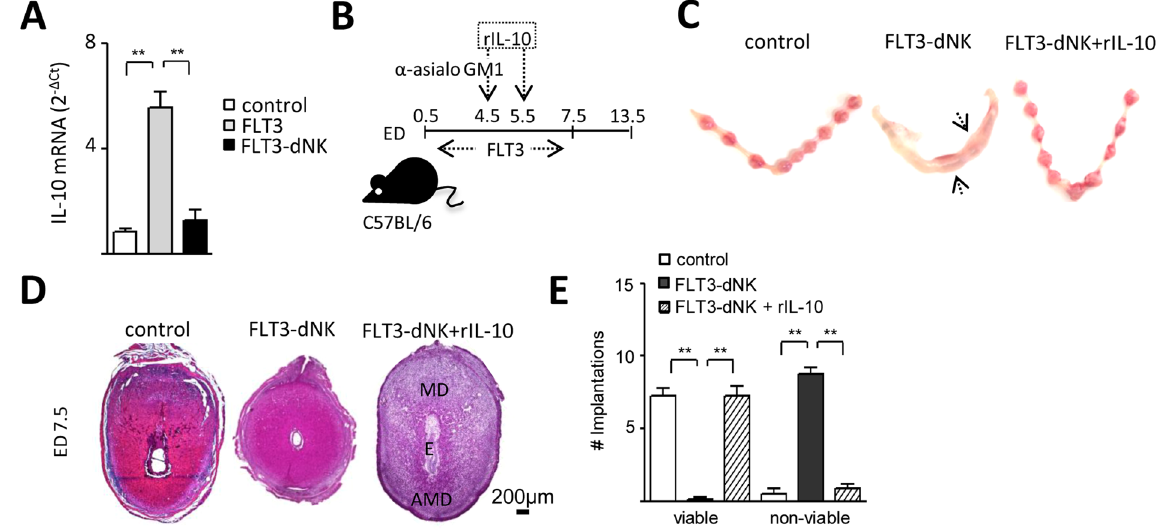
Figure 1. IL-10 rescues pregnancy failure upon NK cell depletion in FLT3-treated dams. ( A ) IL-10 expression in implantation sites from control, FLT3 treated (FLT3) and FLT3 treated- NK cell depleted (FLT3-dNK) pregnant female mice on ED7.5, as analysed by qRT-PCR. ** p < 0.01 ; as assessed by ANOVA, Tukey multiple comparisons test. ( B ) The scheme illustrates the experimental design for DC expansion and NK cell depletion during early pregnancy. Upon plug detection; female mice were injected daily with 10 μ g FLT3 i.p. + a single anti-asialo GM1 injection on ED4.5 to analyze effects of NK cell depletion upon expansion of DC (FLT3-dNK mice). Recombinant IL-10 (rIL-10) was administrated on ED4.5 and ED5.5. ( C ) Macroscopical appearance of the uterus and implantations registered during E7.5. The pictures show the normal phenotype of control and FLT3-dNK + rIL-10 implantations in contrast to that observed in FLT3-dNK mice, which exhibit completely resorbed embryos. ( D ) Microscopical assessment of H&E stained implantation site sections revealed abnormalities in the decidual architecture of dams treated with FLT3 and anti-asialo GM1 (FLT3-dNK), with no distinguishable mesometrial (MD) and antimesometrial pole (AMD) and no signs of developed embryos on ED7.5. Scale: 200 μ m. ( E ) Number of viable and non-viable implantations from dams treated with FTL3 and anti-asialo GM1 (FLT3-dNK) and dams treated also with rIL-10 on ED7.5. Data shown are mean ±